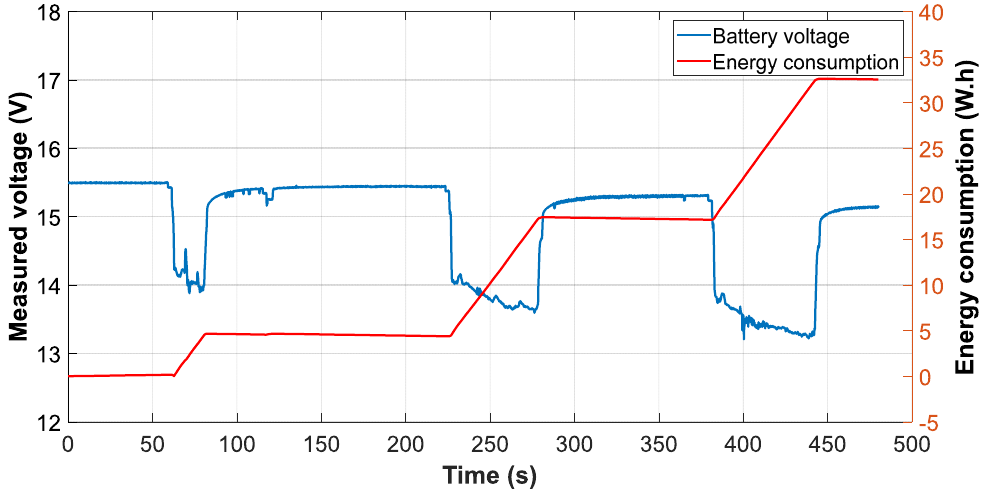
Figure 26. Energy consumption of the system.